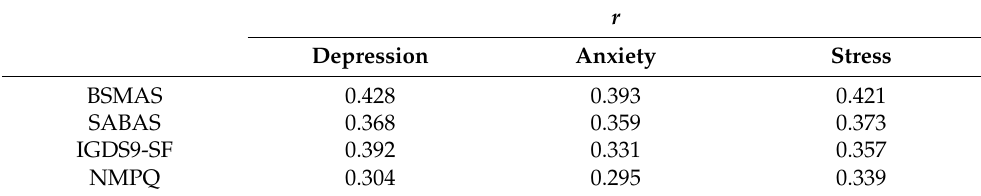
Table 5. Correlation between psychological distress and internet-related